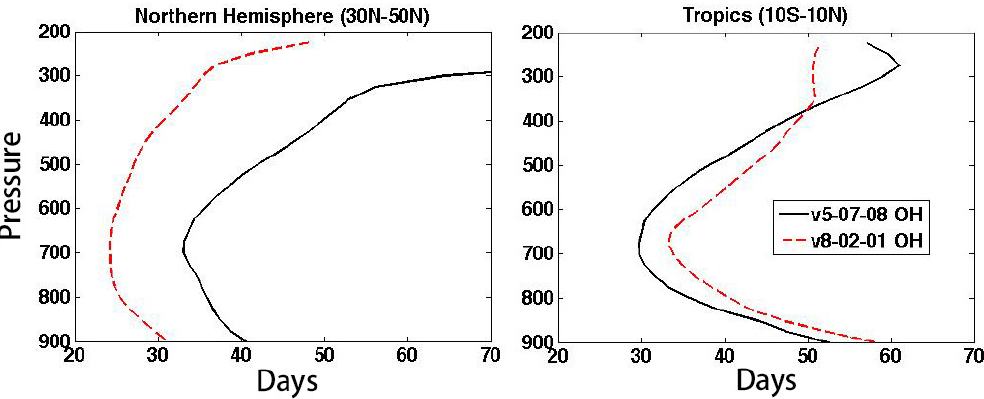
Figure 8. Atmospheric CO lifetime averaged zonally at 30–50 ◦ N and 10 ◦ S–10 ◦ N for August 2004, estimated using v5-07-08 (black solid line) and v8-02-01 (red dashed line) OH